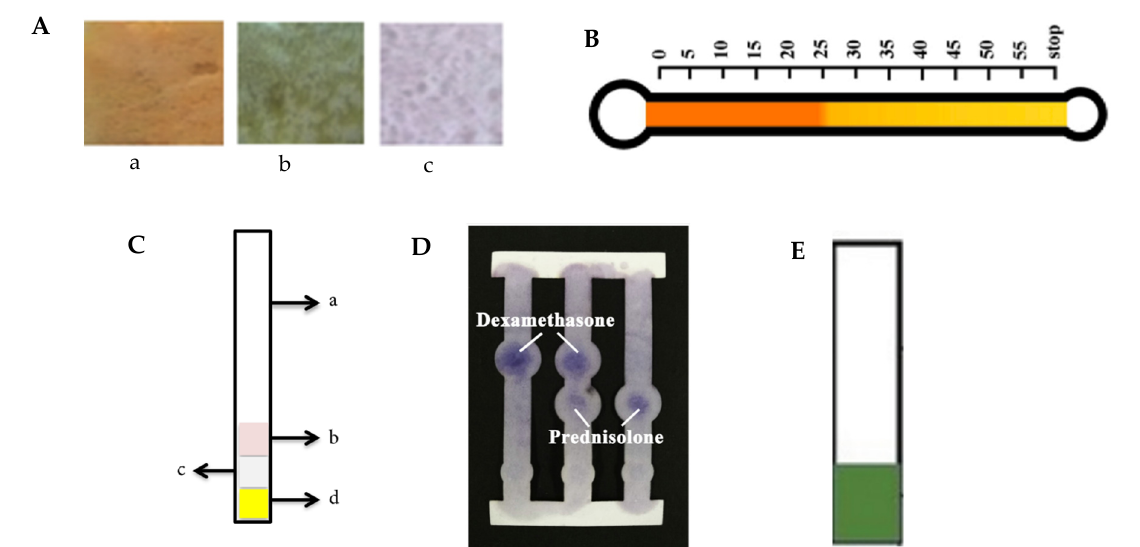
Figure 1. Visualization of the microfluidic analytical device for detection of undeclared synthetic drugs in herbal medicine.